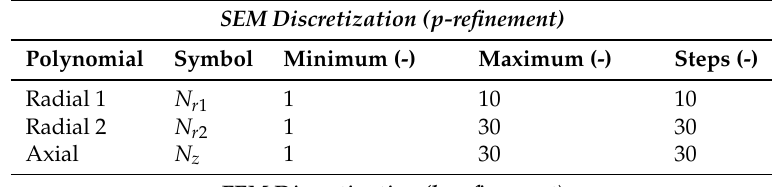
Table 2. Discretization of the polynomial degree (SEM) and mesh points (FEM) evaluated in the convergence analysis.